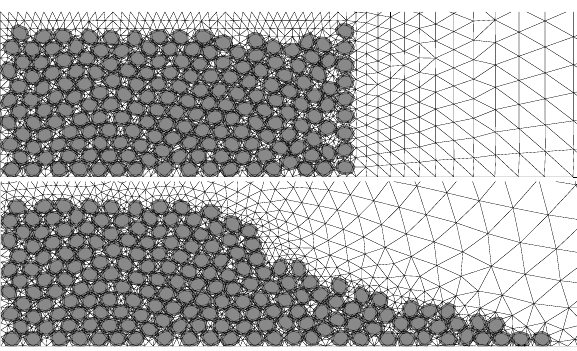
Figure 6. Collapsing granular step. The initially rectangular step is surrounded by a graded mesh (top). After the collapse (bottom) the nodes have slid with the particles to the lower right and vacated areas have integrated with the graded